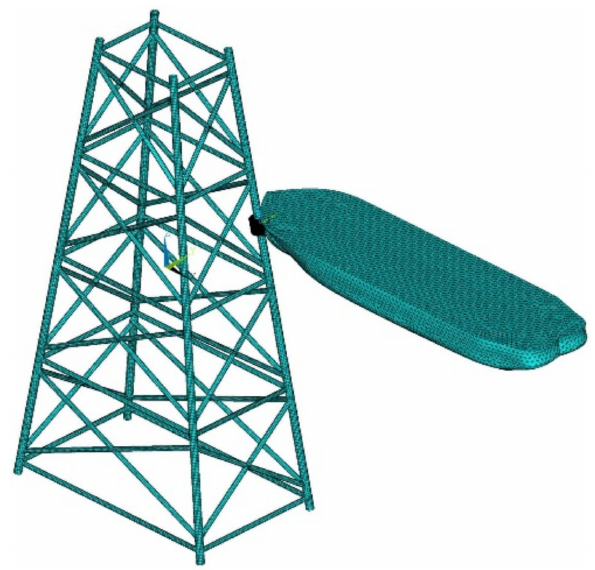
Figure 6. FE model of the ship–platform